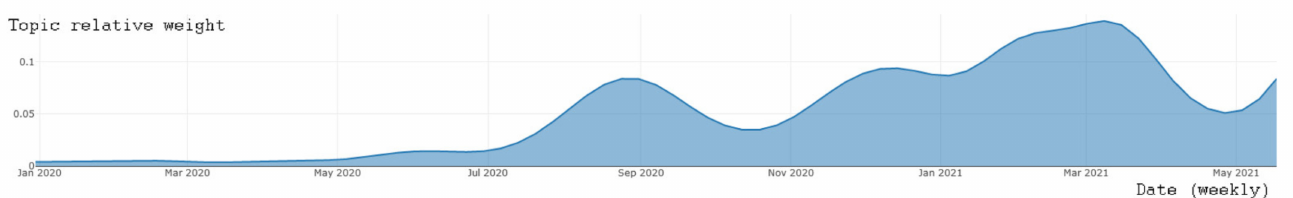
Figure 4. Weekly smoothed dynamics of “Vaccine, Drug, Sputnik-V, Russian, Test” topic relative weight.